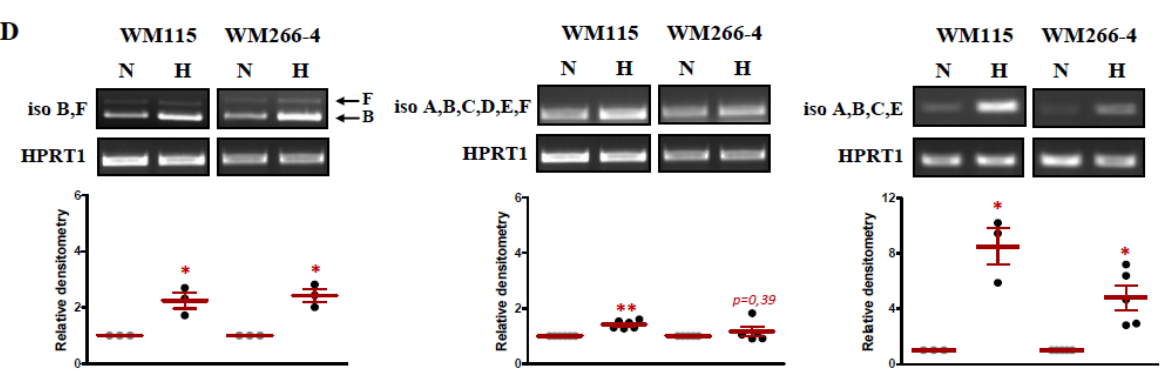
Figure 3. Expression of PFKFB4 isoforms in normoxic and hypoxic conditions. ( A ) The binding position of primers specific to PFKFB4 isoforms. ( B ) Expression of PFKFB4 isoforms: A, C, D, E, and F under normoxic and hypoxic conditions. The expression levels of all isoforms were normalized with respect to isoform C and the fold change values were calculated. The mean ± SEM is shown of three independent experiments. Student’s t -test was used to evaluate the statistical significance. * p < 0.05 by Student’s t -test, ** p < 0.01 by Student’s t -test. ( C ) The influence of 16 h hypoxia on indicated isoforms expression were assessed using RT-qPCR. Expression data for each transcript was normalized to that for the reference gene β -actin, then the expression level of each isoform under hypoxia was normalized with respect to normoxia, and the fold change values were calculated. The mean ± SEM is shown of three independent experiments. Student’s t -test was used to evaluate the statistical significance. * p < 0.05 by Student’s t -test, ** p < 0.01 by Student’s t -test, p -value between 0.05 and 0.1 by Student’s t -test was given as an indication of the trend. ( D ) The influence of hypoxia on the expression of PFKFB4 isoforms including isoform B. The expression levels of indicated PFKFB4 isoforms were assessed using semi-quantitative RT-PCR. HPRT1 was used as an internal control for equal loading. Lower panel: Densitometry analysis of semi-quantitative RT-PCR bands intensity normalized to HPRT1. Each relative densitometry value is the average of at least three independent experiments. The mean ± SEM is shown. Student’s t- test was used to evaluate the influence statistical significance. * p < 0.05 by Student’s t- test, ** p < 0.01 by Student’s t- test, p -value between 0.05 and 0.1 by Student’s t- test was given as an indication of the trend.